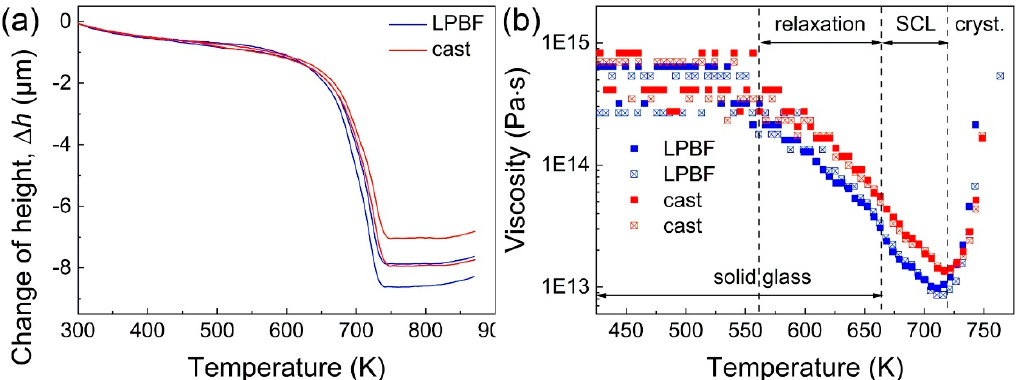
Figure 4. ( a ) Change of sample height ( ∆ h ) as a function of temperature for the cast and LPBF specimens obtained by parallel plate rheometry and ( b ) corresponding temperature dependence of the viscosity of the supercooled liquid (SCL) derived using Equation (1). The characteristic temperature ranges where structural relaxation and crystallization occur are shown in ( b ) along with the range where the glassy solid transforms into the SCL.